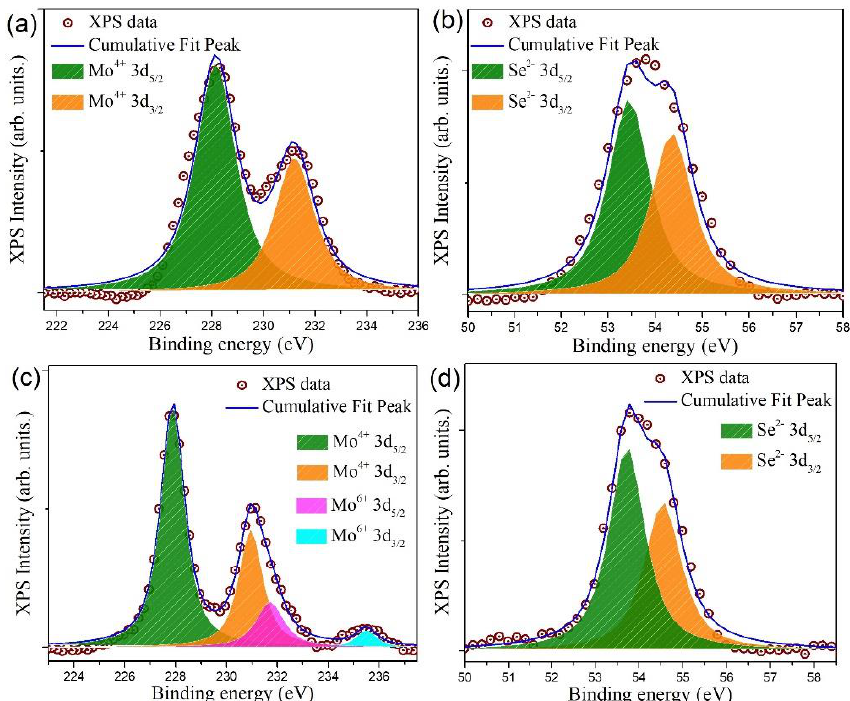
Figure 4. High-resolution X-ray photoelectron spectrometer (XPS) spectra showing the binding energy of ( a ) Mo 3d and ( b ) Se 3d electrons recorded on bulk MoSe 2 powder. High-resolution core level spectra corresponding to ( c ) Mo 3d and ( d ) Se 3d electrons for MoSe 2 QDs.